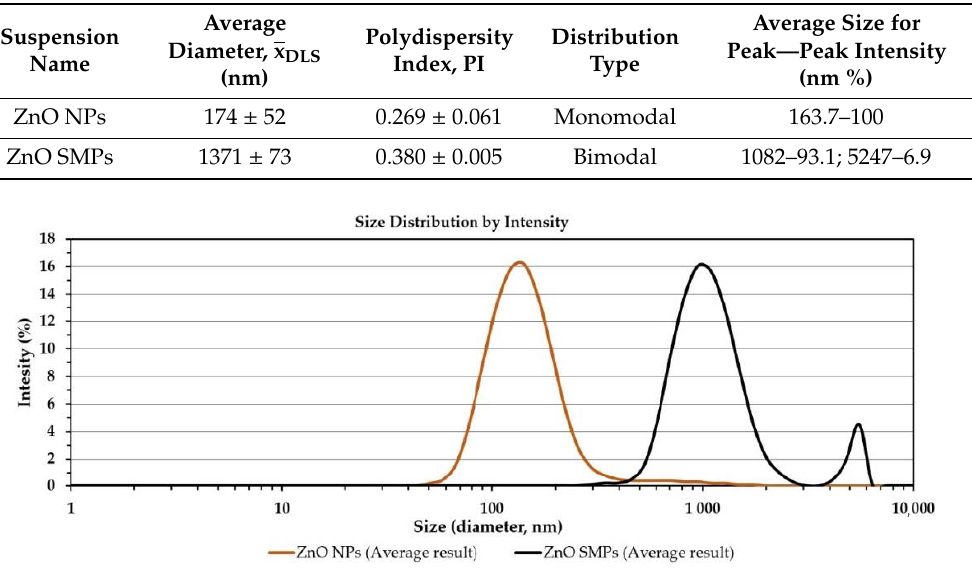
Table 2. Results of average particle size of ZnO in suspensions with the concentration of 100 ppm.